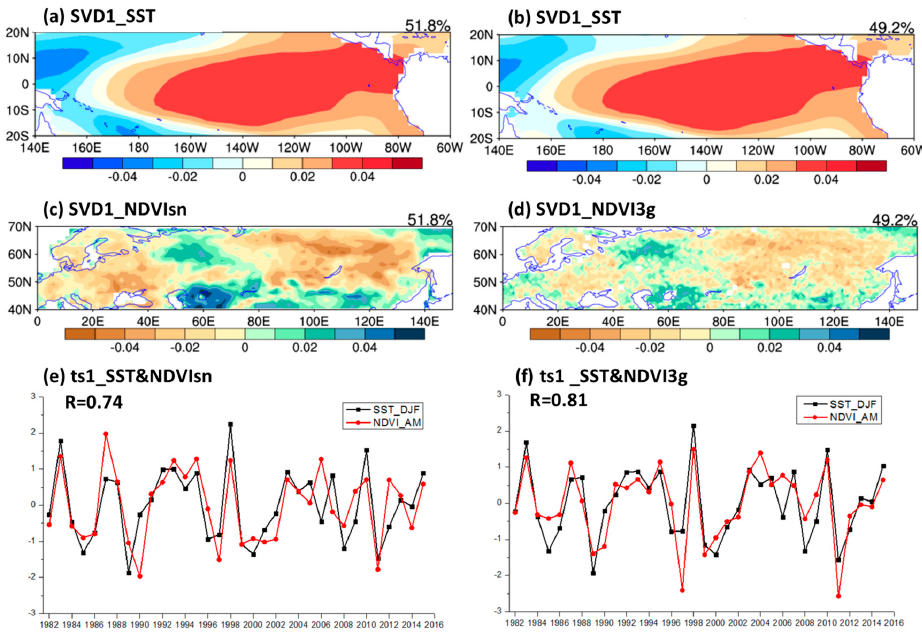
Figure 4. Spatial patterns and time-series of expansion coefficients for the first leading paired mode of winter SST (tropical Pacific) and spring NDVI (Eurasia) for the period 1982 to 2015 via the SVD analysis: ( a ) the paired mode of SST using NDVIsn; ( b ) the paired mode of SST using NDVI3g; ( c ) the paired mode of NDVI using NDVIsn; ( d ) the paired mode of NDVI using NDVI3g; ( e ) the time-series of SST (black squares) and NDVI (red dots) using NDVIsn; ( f ) the time-series of SST (black squares) and NDVI (red dots) using NDVI3g. The time-series amplitudes are normalized based on standard deviation. The variance explained by each SVD is shown on the right corner in ( a – d ).